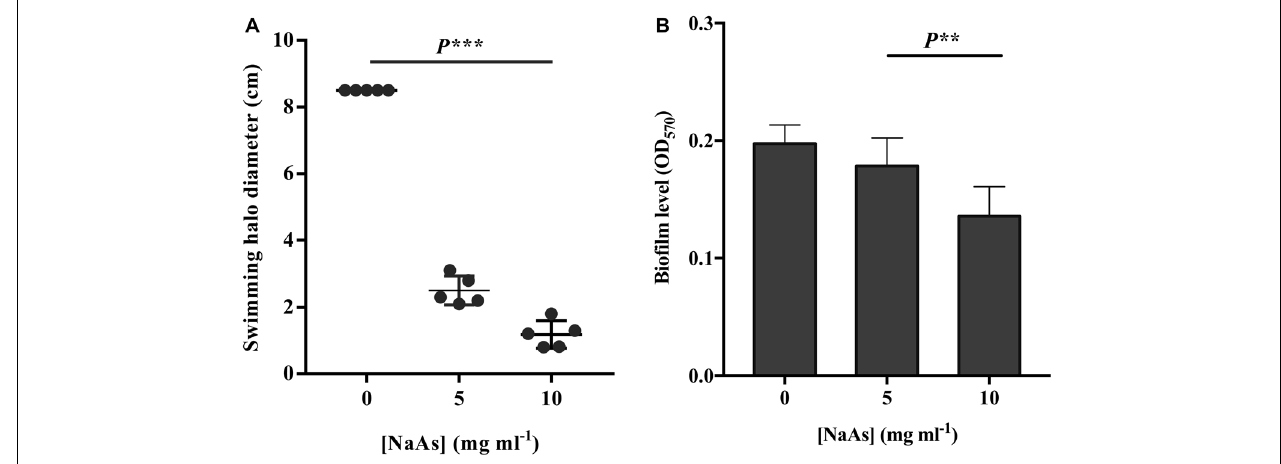
FIGURE 3 | (A) Impact of NaAs on swimming motility of V. campbellii on soft agar plates. (B) Impact of NaAs on the biofilm levels on polystyrene 96-well plates. The error bar represents the standard deviation of five replicates for swimming motility and six independent experiments for biofilm. P ∗∗ in the graph indicates P < 0.01 and P ∗∗∗ indicates P < 0.001 (One-way ANOVA with Duncan’s post hoc test).